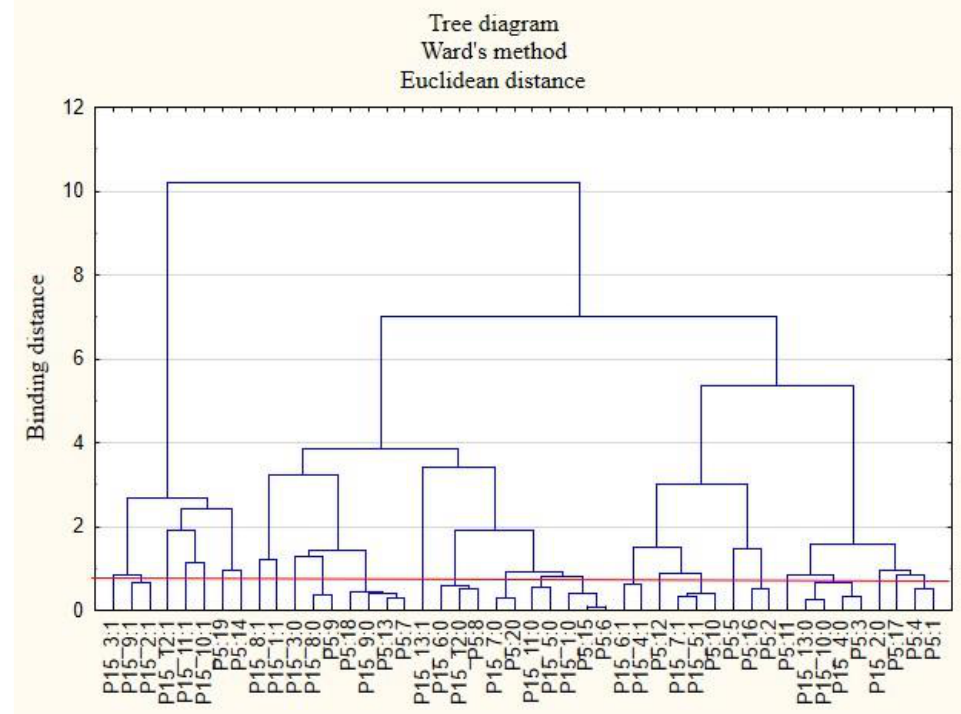
Figure 4. Diagram of hierarchical classification of variable categories: support received during the COVID-19 pandemic from the employer in the area of health care and the effective use of the benefits offered (P15) as well as the industries in which the respondents work (P5).